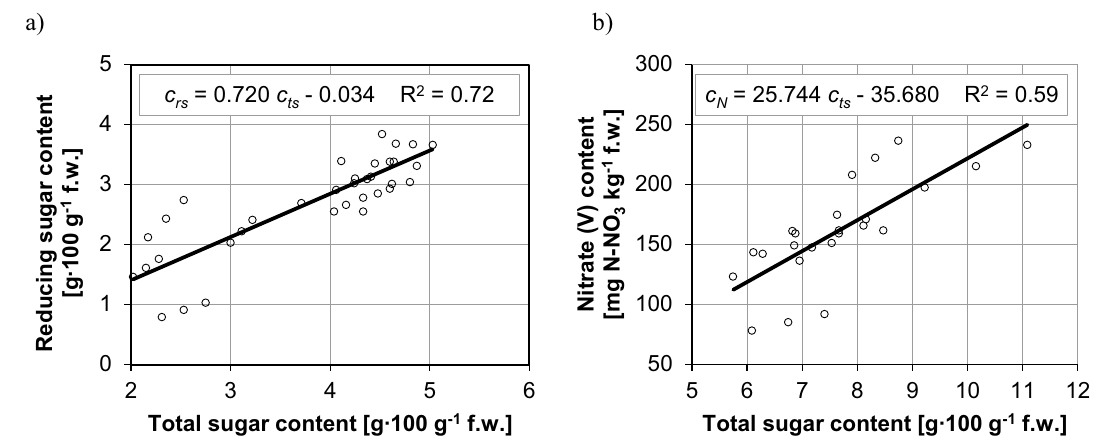
Figure 4. Relationships between the chemical composition of Capsicum annuum fruit: ( a ) total sugar content and reducing sugar content of sweet peppers, ( b ) total sugar content and nitrate (V) content of hot